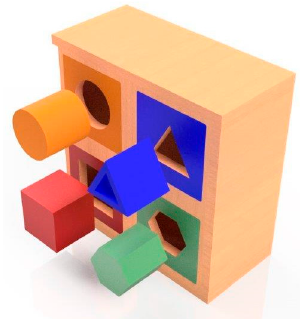
Figure 14. Configured sorting box.